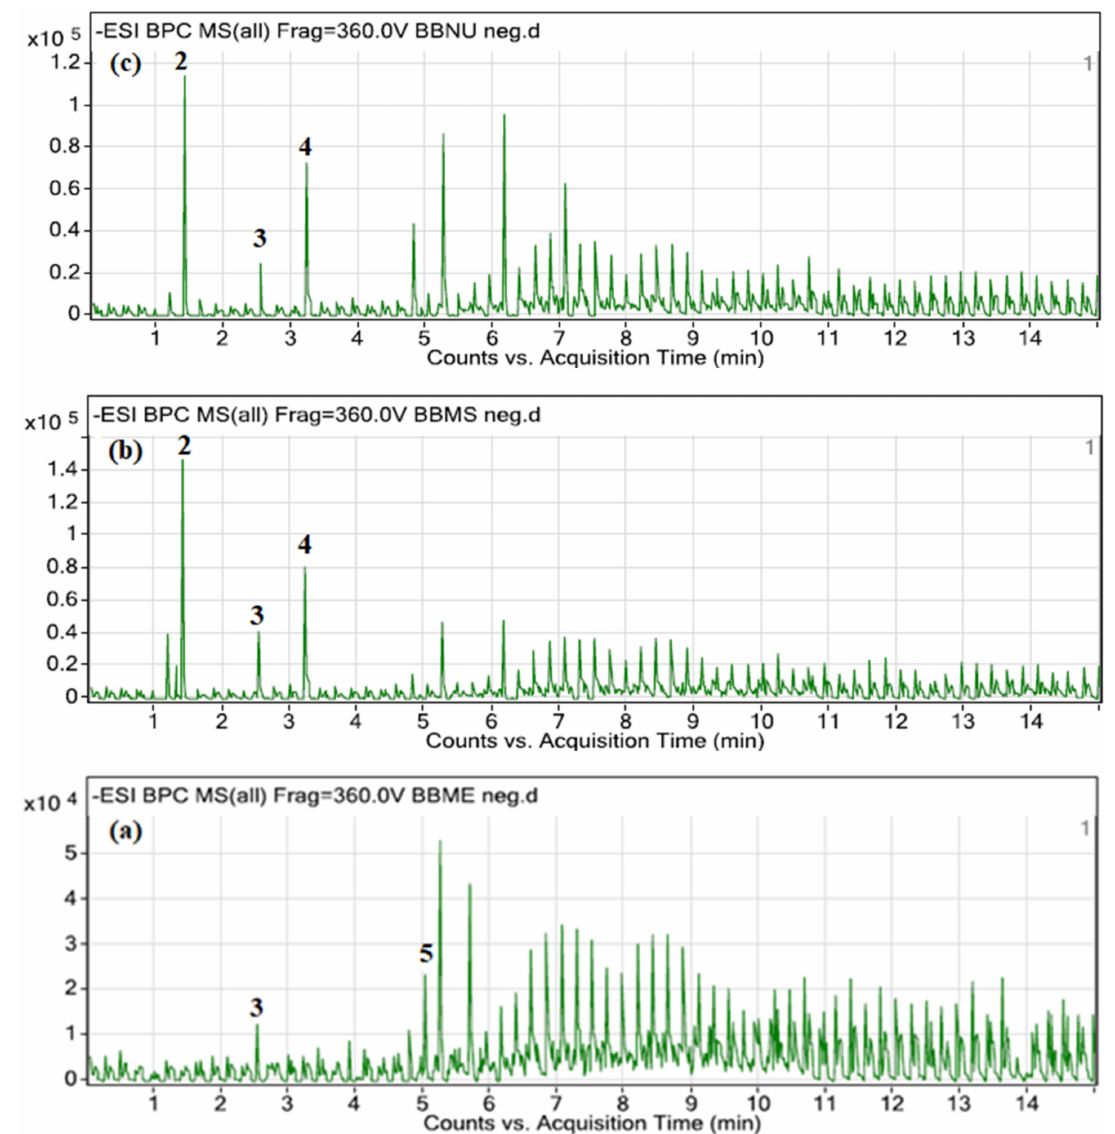
Figure 3. Total ion chromatogram (TIC) of: ( a ) BBMR, ( b ) BBMS, and ( c )